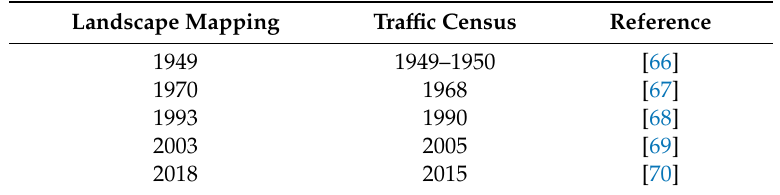
Table 2. The national tra ffi c censuses and landscape structure mapping in